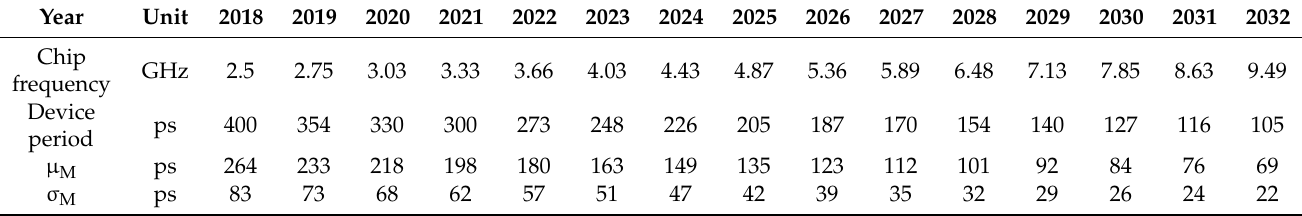
Table 1. IEEE International Roadmap for Devices and Systems (2017